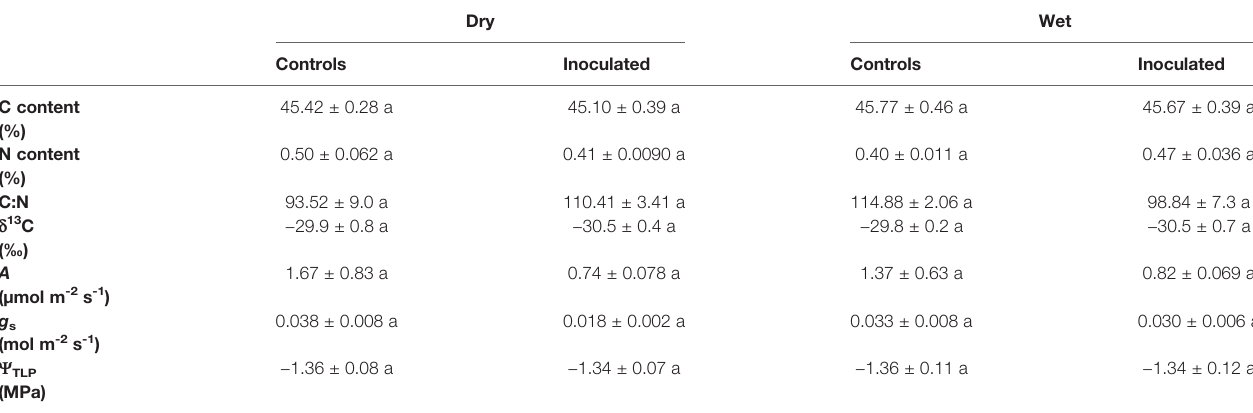
Letters indicate statistically signi fi cant differences among groups at P ≤ 0.05. All values are expressed as means ± SE. N = 4. Seedlings were ~11 months old.